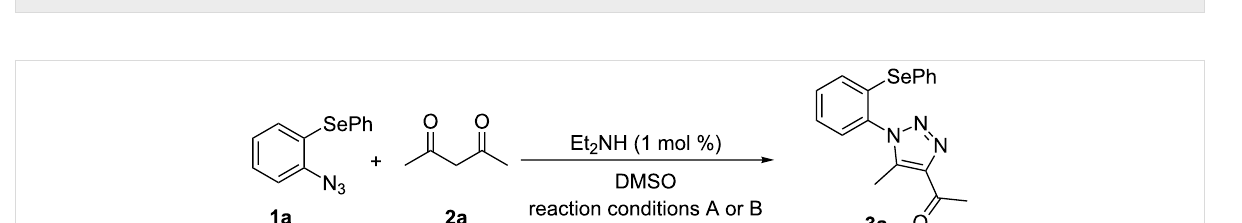
Scheme 1: General scheme of the reaction.